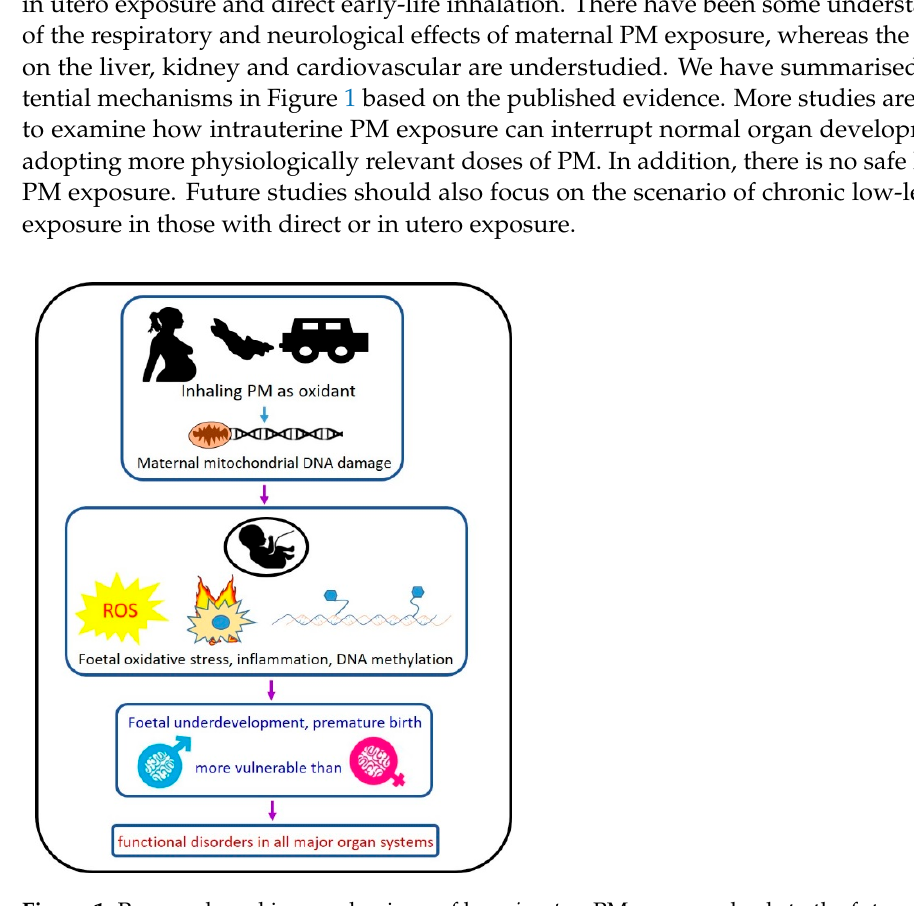
Figure 1. Proposed working mechanisms of how in-utero PM exposure leads to the future develop- ment of organ disorders.